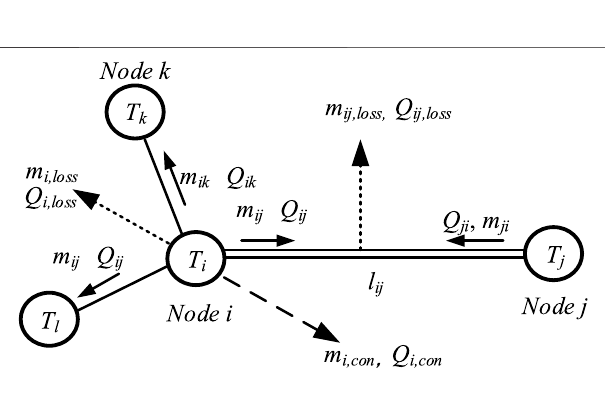
FIGURE 2 | General transmission model of the heating